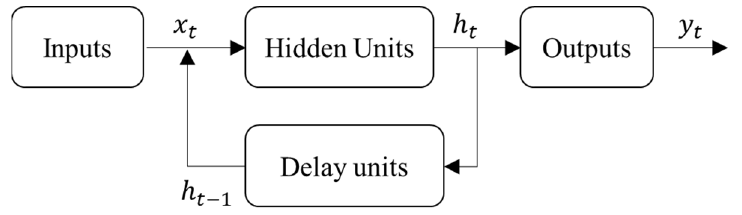
Figure 1. ( a ) ARIMA algorithm schematic; ( b ) ARIMA model assumptions where Y (cid:2930) = ) (cid:3397) e f(Y (cid:2930)(cid:2879)(cid:2921) ,e (cid:2930)(cid:2879)(cid:2921) (cid:2930) and 𝑘 (cid:3408) 0 .